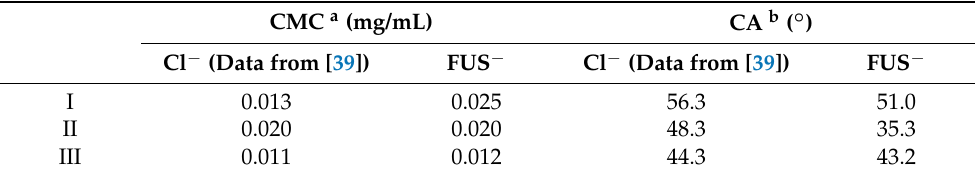
Table 2. Characterization of aqueous solution and surface wettability for graft copolymers and their conjugates with FUS − .